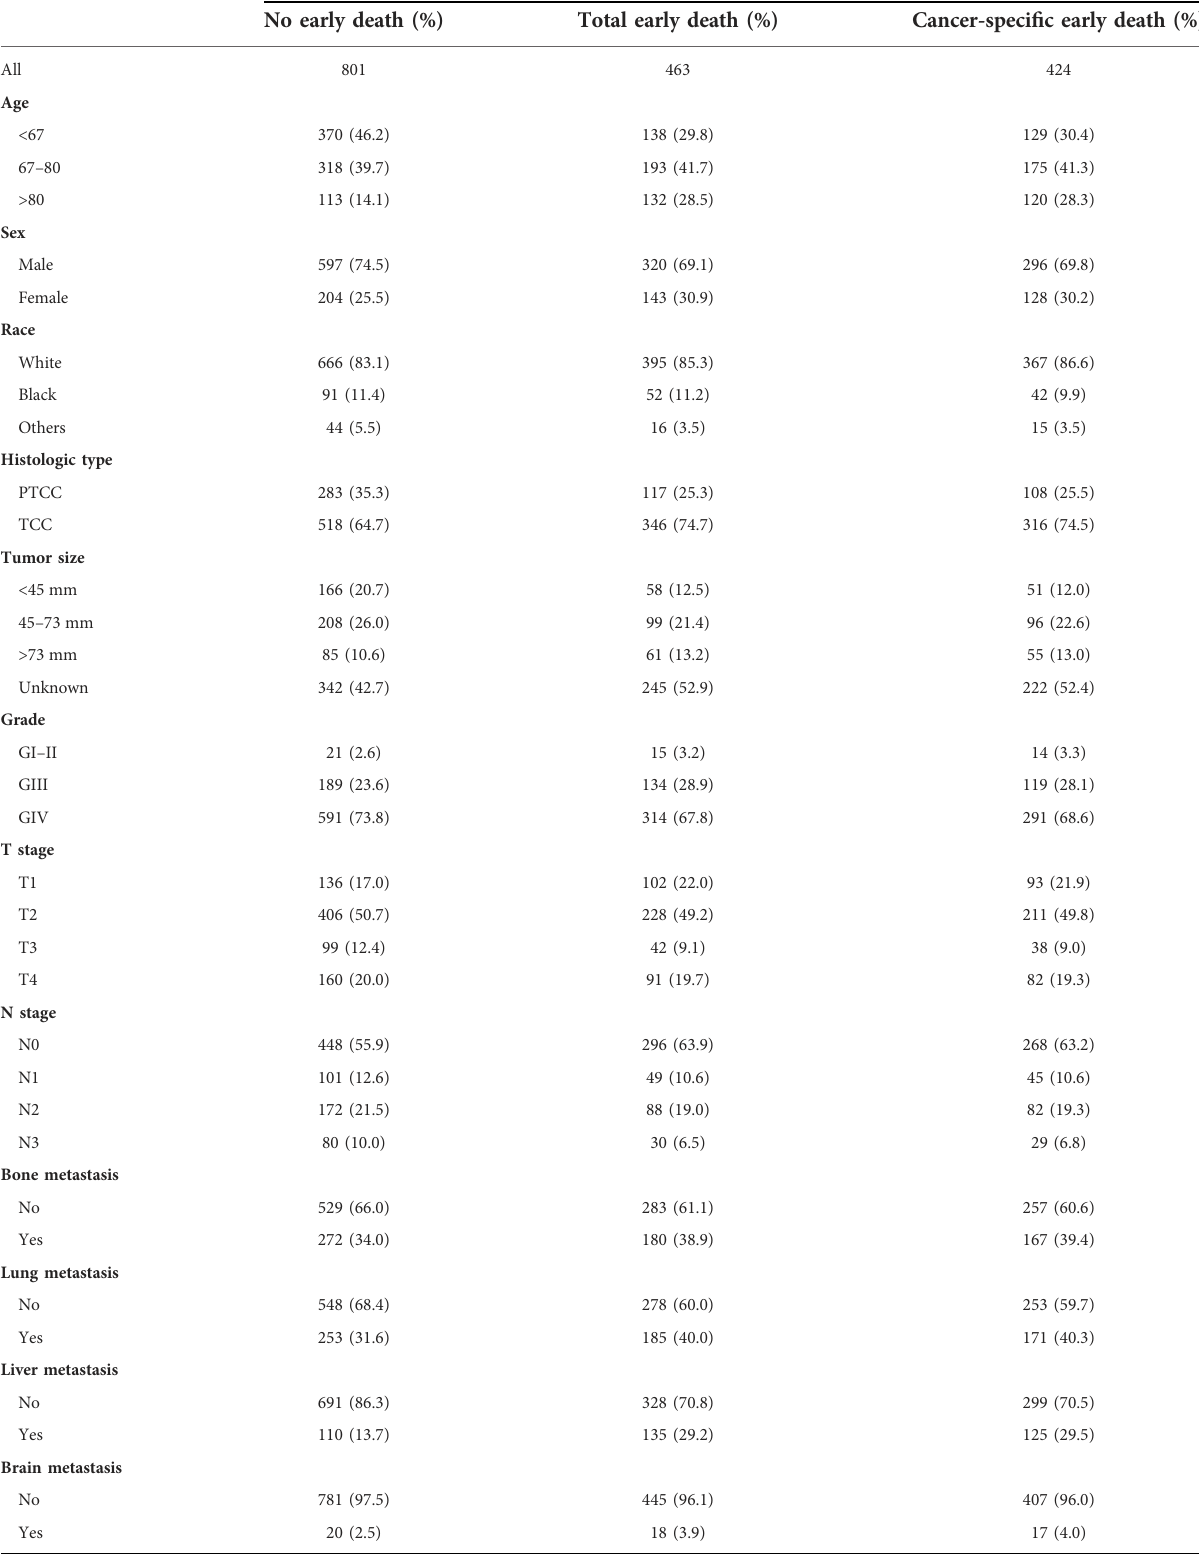
TABLE 1 Characteristics with metastatic bladder cancer